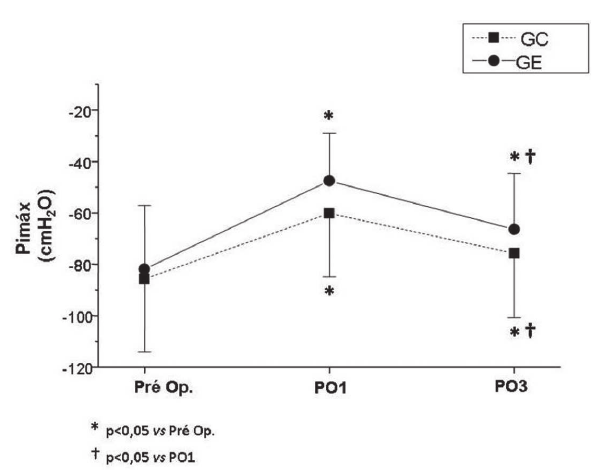
Fig. 1 – Pimáx. Evolução das medidas de Pimáx nos grupos estudados